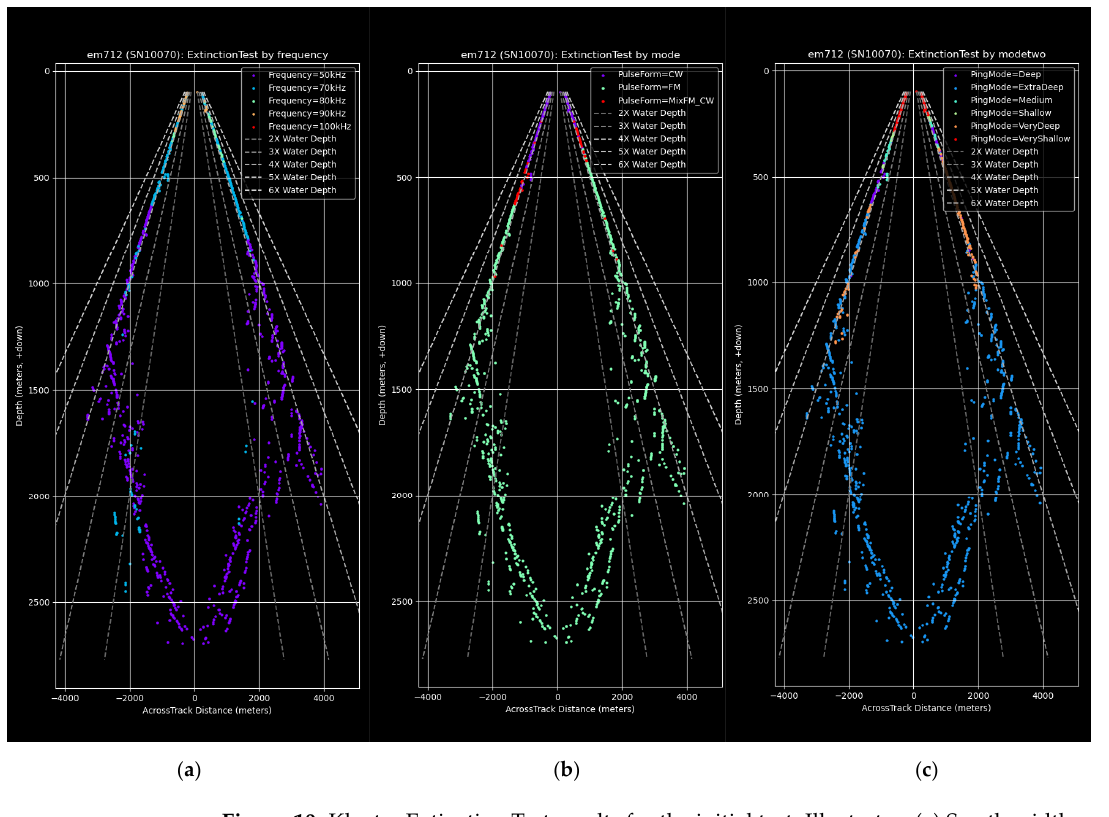
Figure 10. Kluster Extinction Test results for the initial test. Illustrates: ( a ) Swath width versus depth colored by frequency; ( b ) Swath width versus depth colored by the first mode value, which is either a Continuous Wave (CW) pulse or a Frequency Modulated (FM) pulse; ( c ) Swath width versus depth colored by the second mode value, which is the Kongsberg Ping Mode.